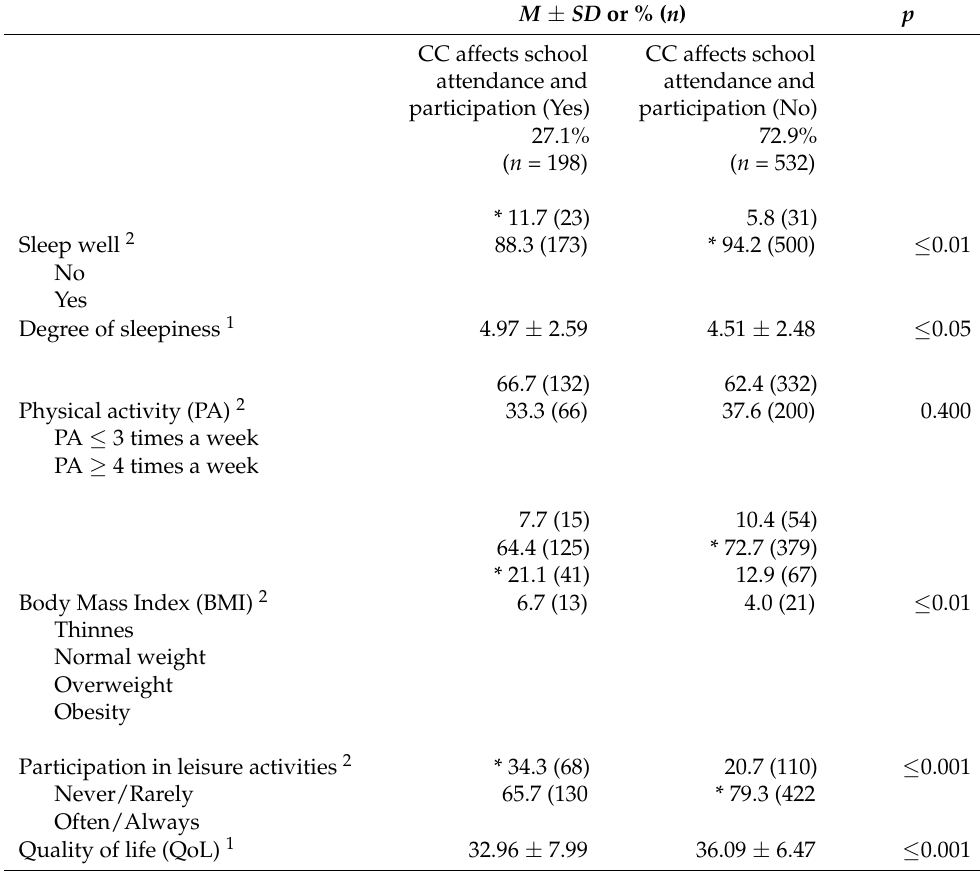
Table 3. Bivariate analysis of differences between adolescents with and without school attendance and participation affected by the CC.